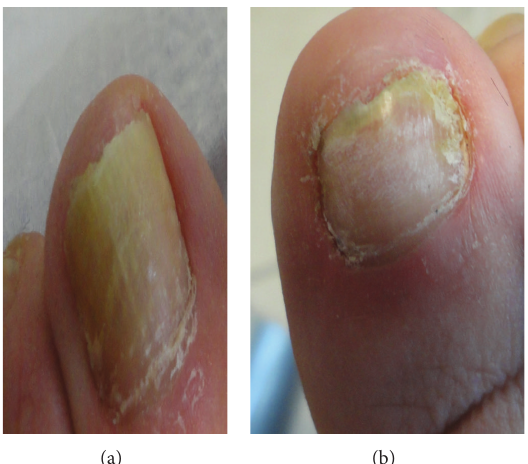
Figure 2: (a) 64-year-old female patient before treatment. Trichophyton rubrum was isolated on mycological testing. OSI is 26. (b) After treatment with great improvement. OSI is 9 showing 65.38% improvement.